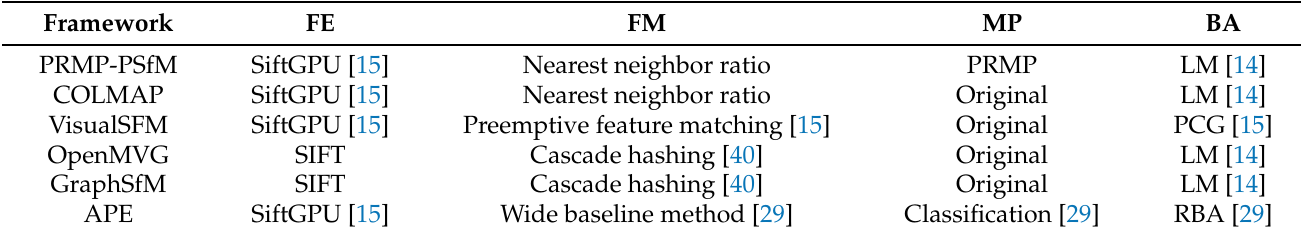
Table 1. Some properties of the methods used in our experiments: FE—feature extraction; FM—feature matching; MP— match pairs; BA—bundle adjustment; PRMP—prioritizing and refining match pairs; LM—Levenberg–Marquardt; PCG— preconditioned conjugate gradient; RBA—robust bundle adjustment. “Original” indicates that the original view-graph is taken as input and there is no specified process on its match pairs. “-” indicates that the corresponding items are unavailable.